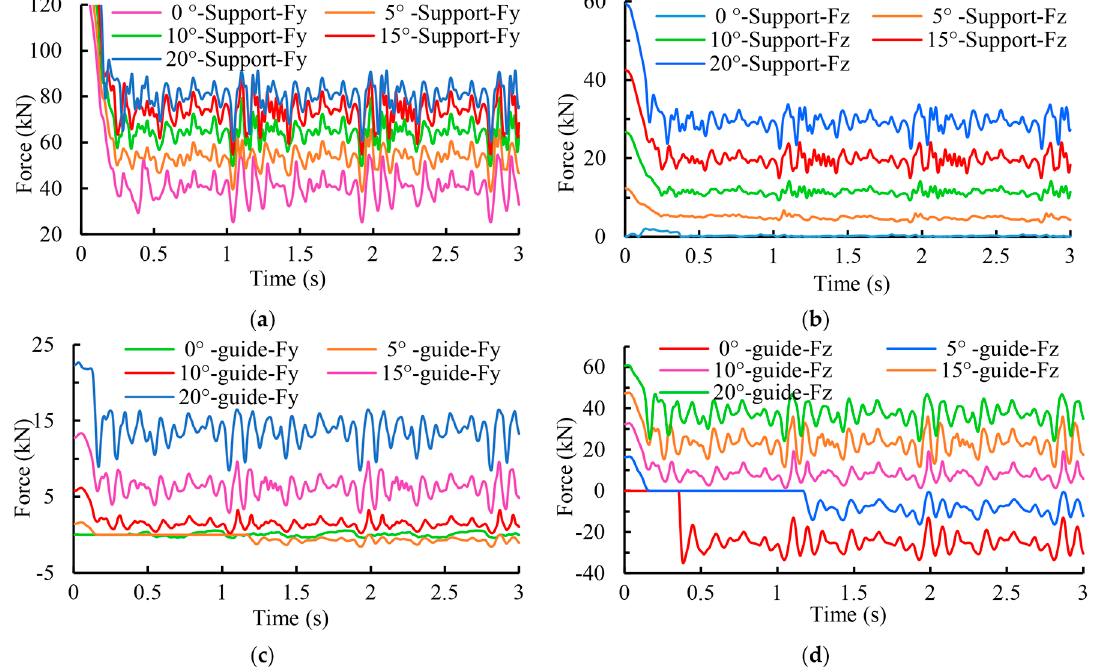
Figure 10. Mechanical property of the slipper under different depression angle: ( a ) The supporting force of the support slipper; ( b ) The longitudinal force of the support slipper; ( c ) The supporting force of the guide slipper; and ( d ) The longitudinal force of the guide slipper.